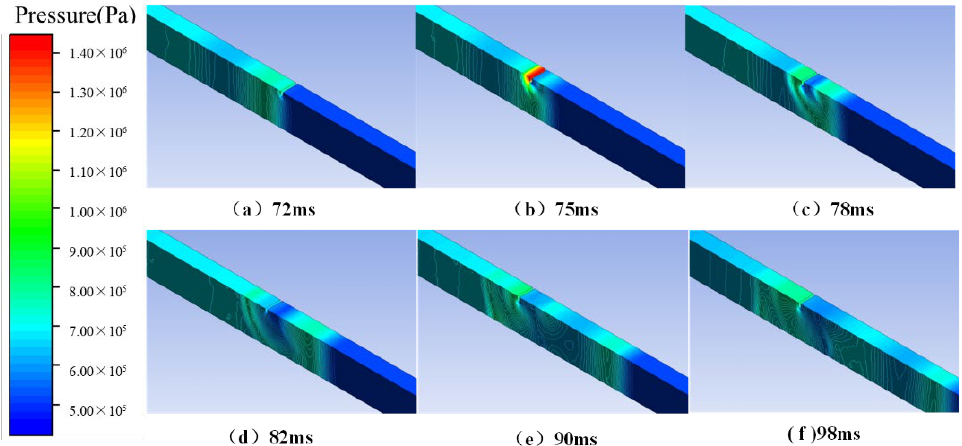
Figure 12. Overpressure cloud image of the baffle and the wall of the gas cabin when the spacing is 70 m.